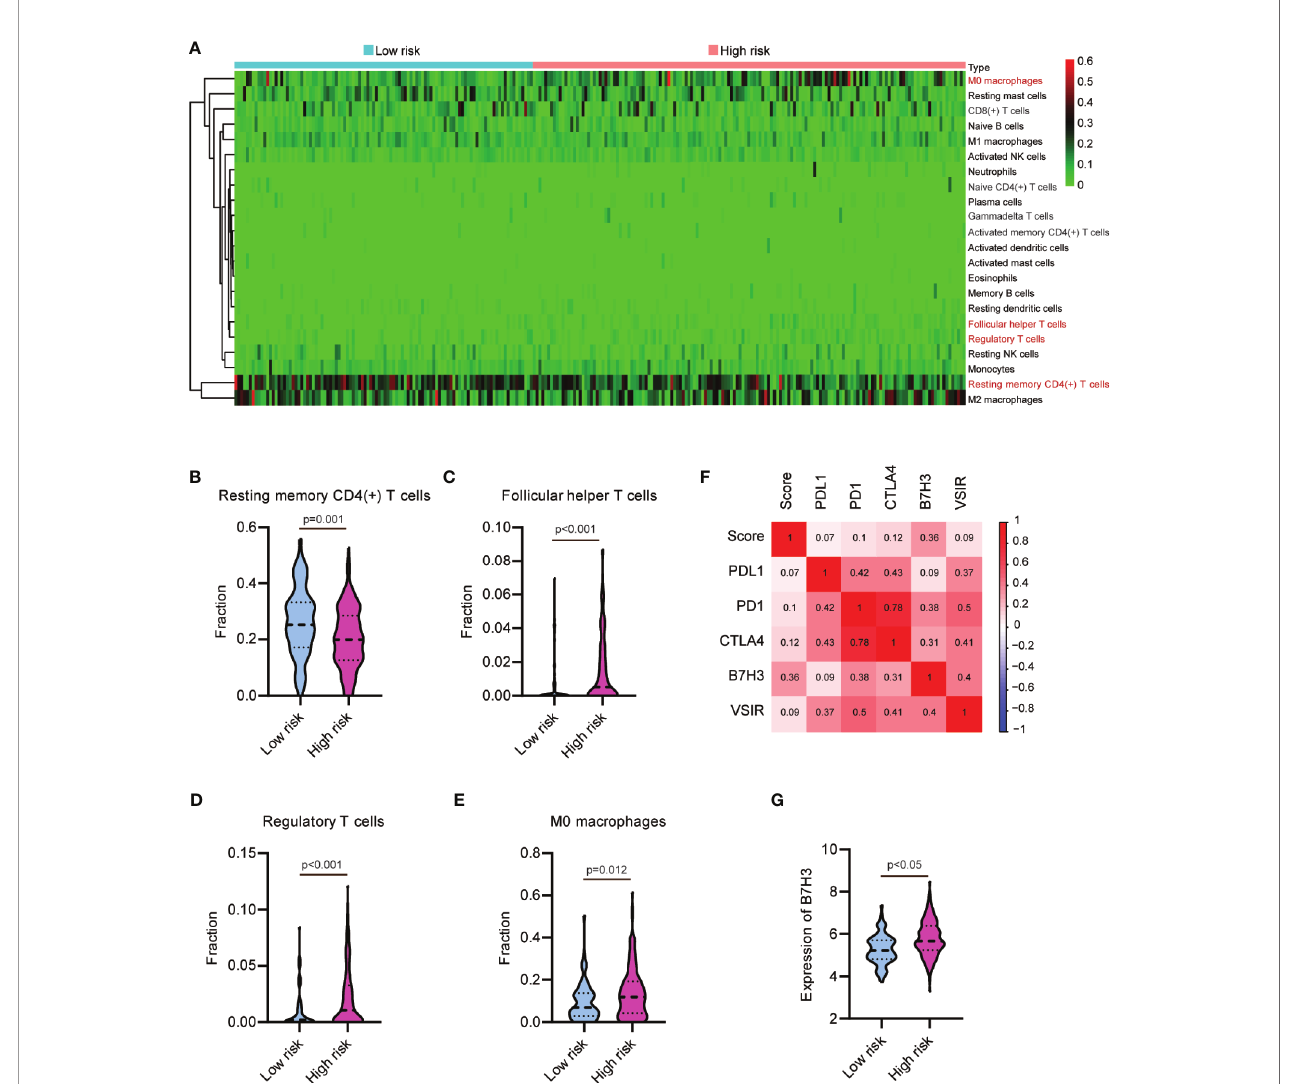
FIGURE 7 | Relationship between the lncRNA-based signature and immune responses in hepatocellular carcinoma. (A) Heat map of immune responses based on CIBERSORT in the low-risk group and the high-risk group. The proportion of (B) resting memory CD4(+) T cell, (C) follicular helper T cells, (D) regulatory T cells, and (E) M0 macrophages in the low-risk group and the high-risk group. (F) Heat map showing the positive relations between risk score and several immune checkpoints. (G) B7H3 is upregulated in the high-risk